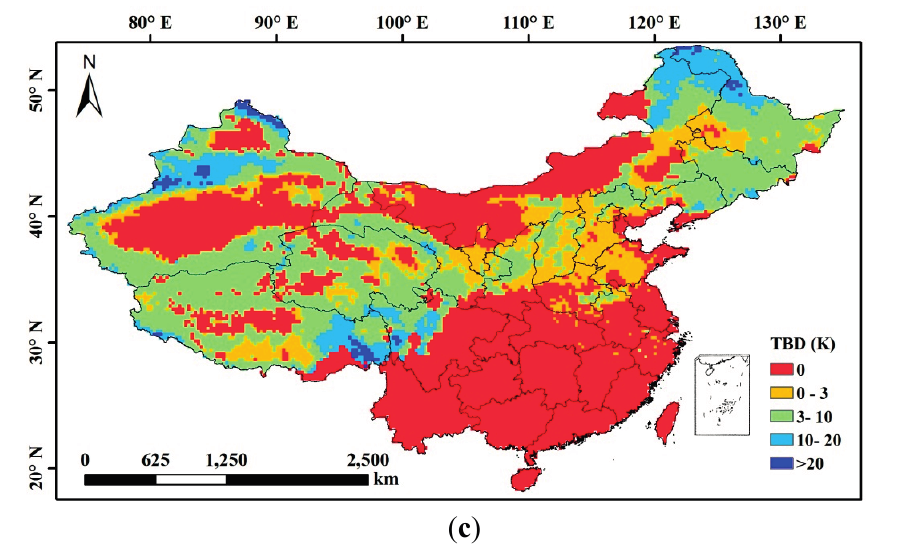
Figure 7. Spatial distribution of snow cover fraction (SCF) from the IMS ( a ) and in TBD from F17 ( b ) and F13 ( c ) over China on 1 January